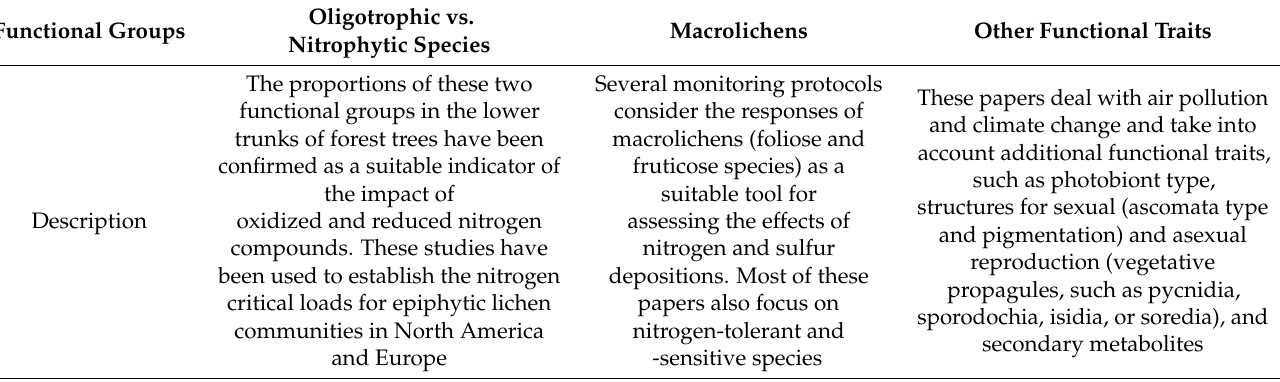
Table 2. Lichen functional groups: list of selected